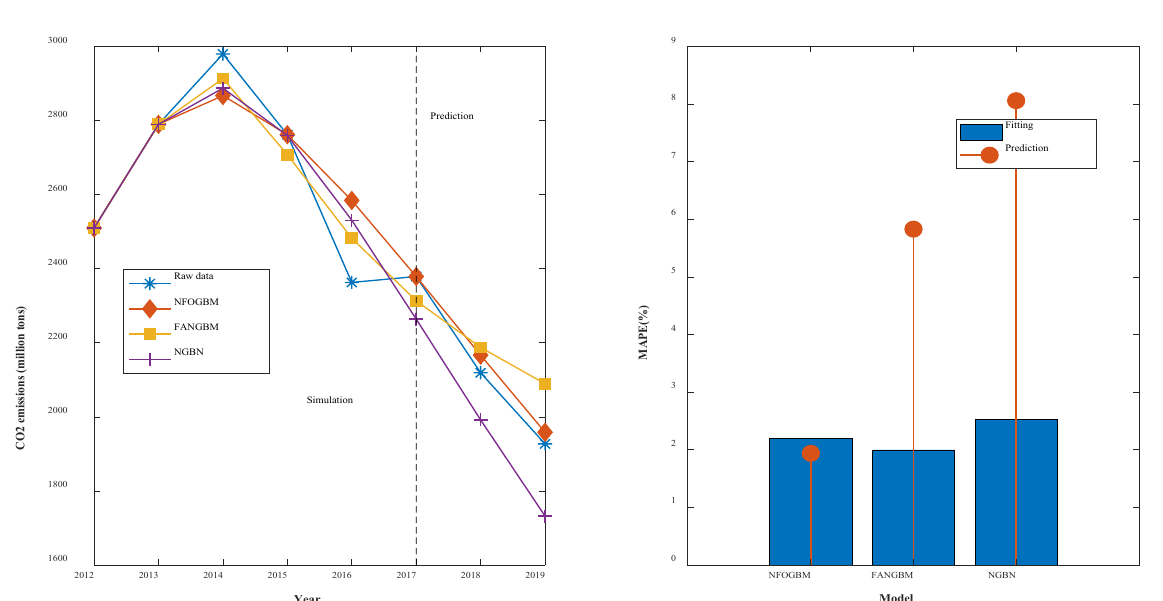
Figure 7. Fitting curves and error plots of the NMMD results. (6) The modeling results for CMD are shown in Table 7, and the fitting and error plots are shown in Figure 8. The MRPESs (%) of the NFOGBM, FANGBM, and NGBM are 4.112, 3.406, and 4.459, respectively; the MRFPEs (%) are 0.519, 4.104, and 11.146, respectively, and the CMRPEs (%) are 3.727, 4.007, and 6.688, respectively. In this example, the NGBM does not capture the changes in the new data, and the corresponding modeling curve displays an upwards trend in the prediction phase, seriously deviating from the original data. Both the NFOGBM and the FANGBM can use all available information in modeling, and the NFOGBM greatly improves upon the traditional grey Bernoulli model by utilizing new data, yielding the lowest prediction error and comprehensive error, and providing the optimal modeling